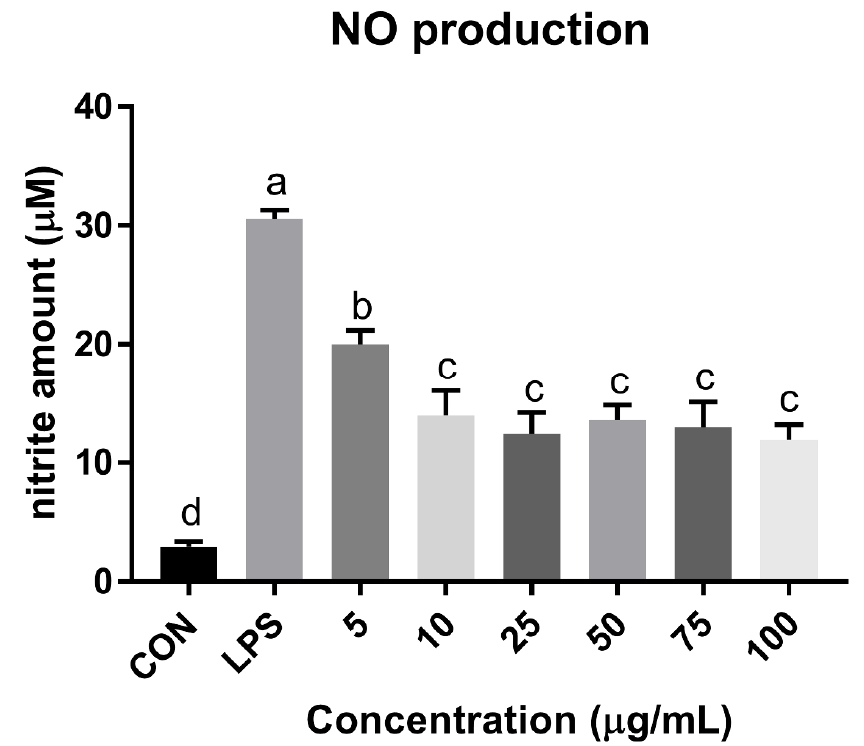
Figure 5. Nitric oxide reduction effects of mealworm chitosan on lipopolysaccharide (LPS)-stimulated murine macrophage cell line (RAW 264.7). Different superscripts (a–d) indicate significant differences at p < 0.05.